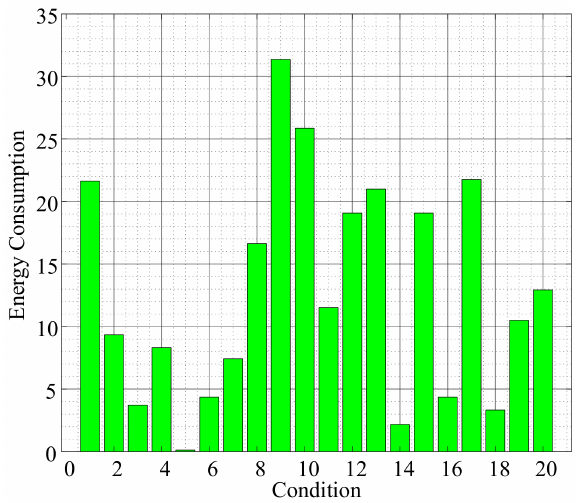
Figure 14. Energy for third line